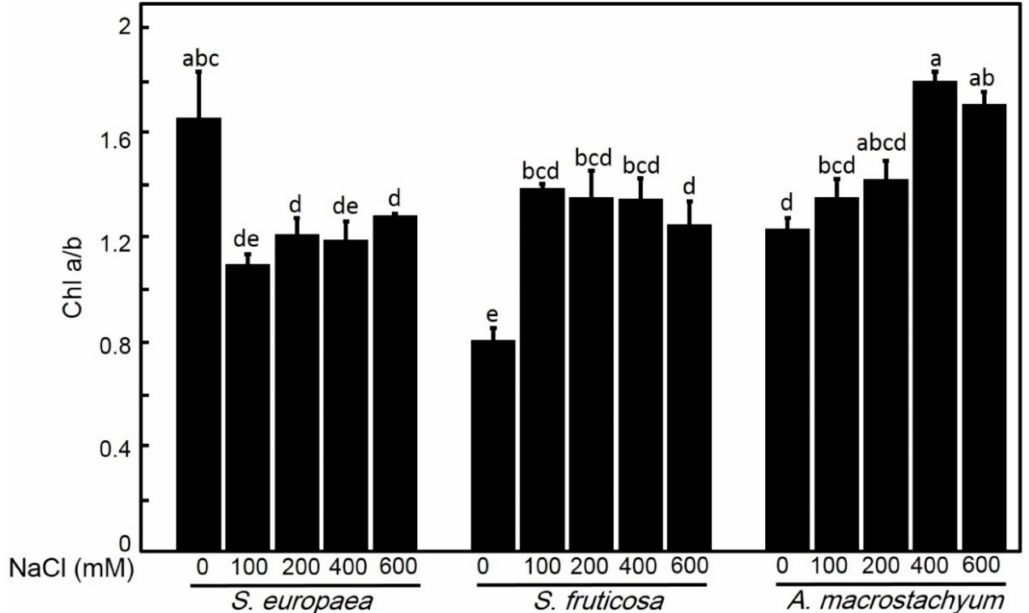
Figure 7. Chlorophyll a/b ratios of S. europaea, S. fruticosa and A. macrostachyum under different NaCl concentrations. Mean ± SE of three replicates. Different letters indicate significant differences ( p < 0.05).